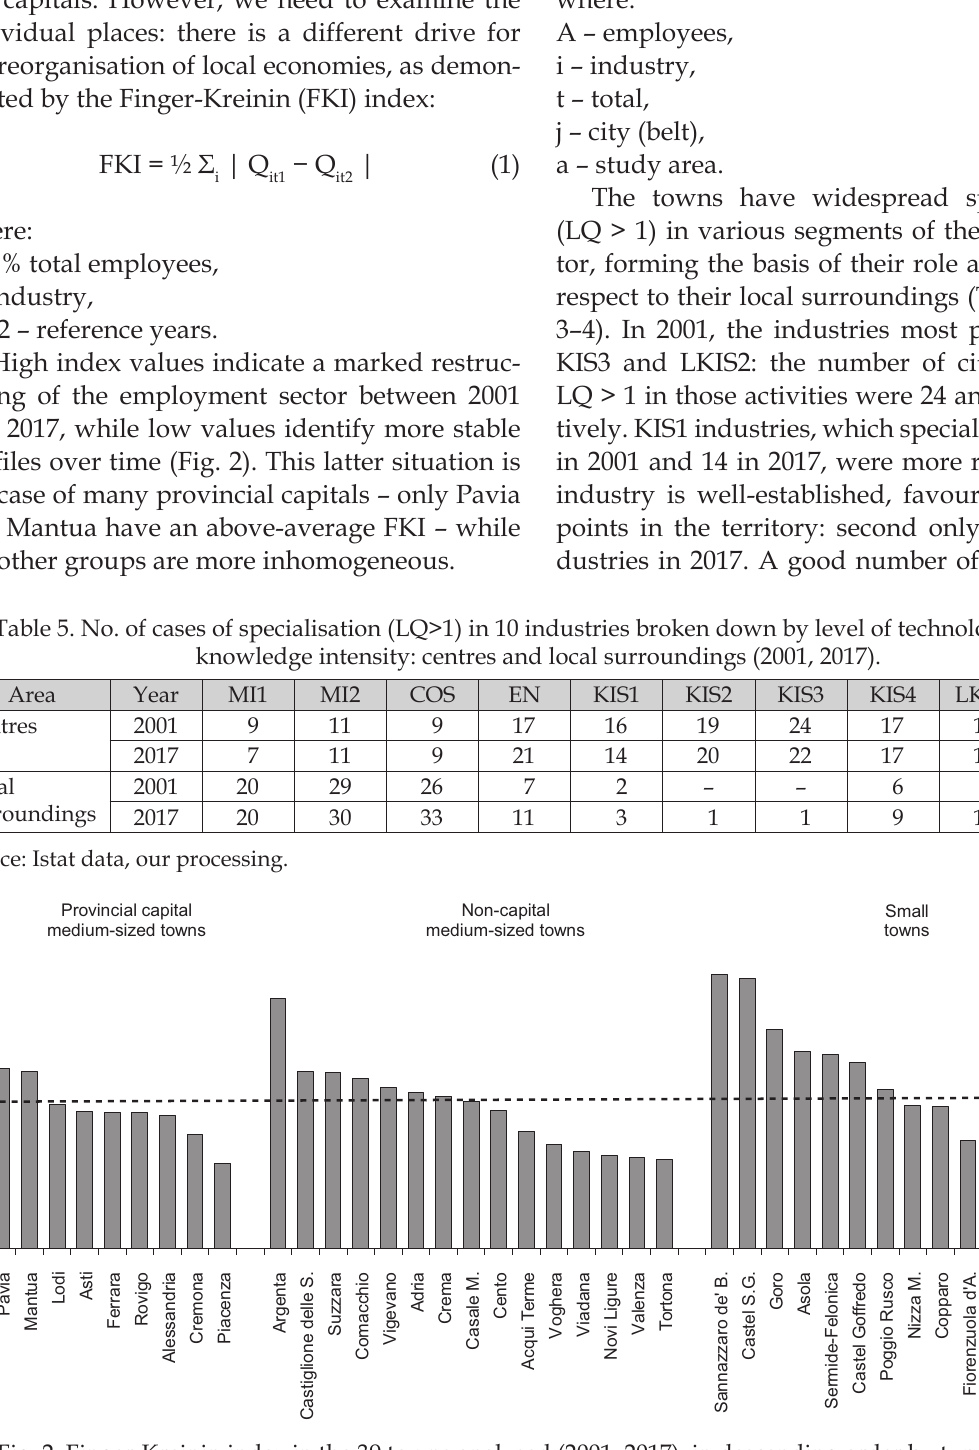
Fig. 2. Finger-Kreinin index in the 39 towns analysed (2001–2017), in descending order by type of